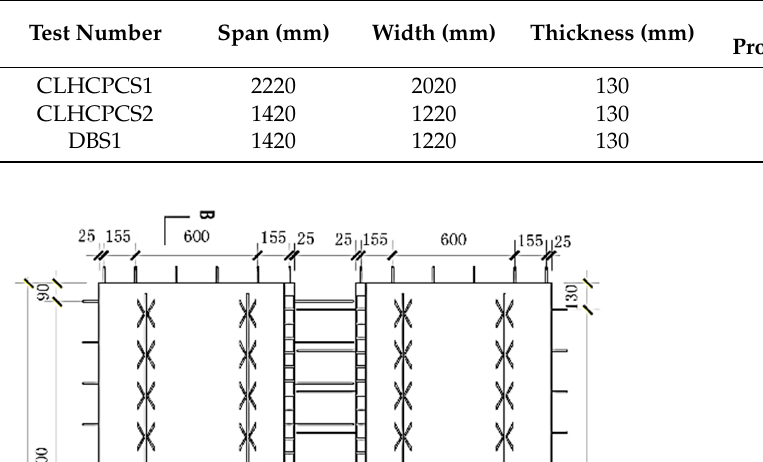
Table 9. The specific dimensions of each specimen table.